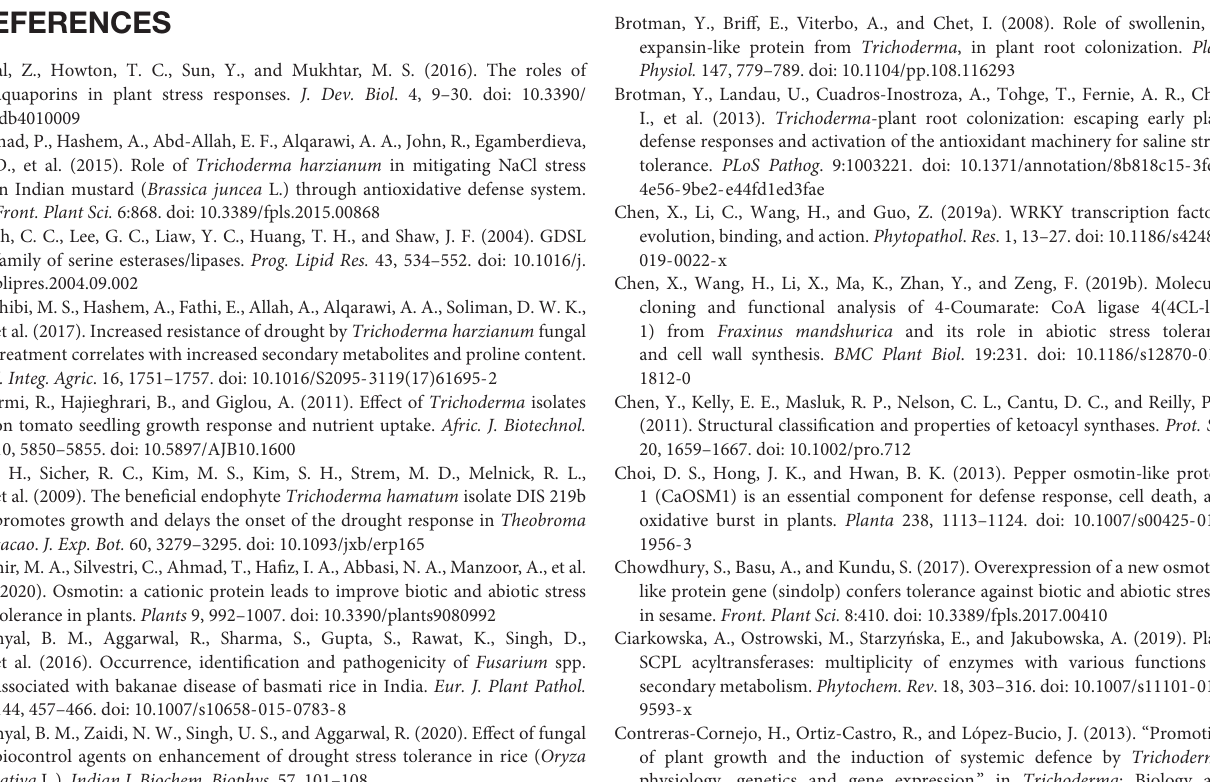
Supplementary Figure 1 | Effect of T. harzianum treatment in drought stressed rice cultivars’ (IR64 and Shahbhagi Dhan) root length (A–C) and shoot length (D–F) after different days (4, 7, and 10 days) of drought stress. Supplementary Figure 2 | Effect of T. harzianum treatment on plants of two rice varieties (V1, Shahbhagi Dhan and V2, IR64) after different days (4 and 7 days) of drought stress where a, b, and c represent control, T. harzianum treated + drought stress and drought stressed plants in each image. Supplementary Table 1 | List of primers used for expression analysis.